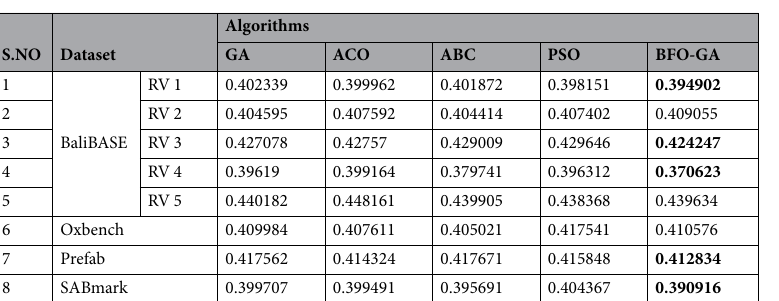
Table 2. RF Distances of the Inferred Phylogenetic